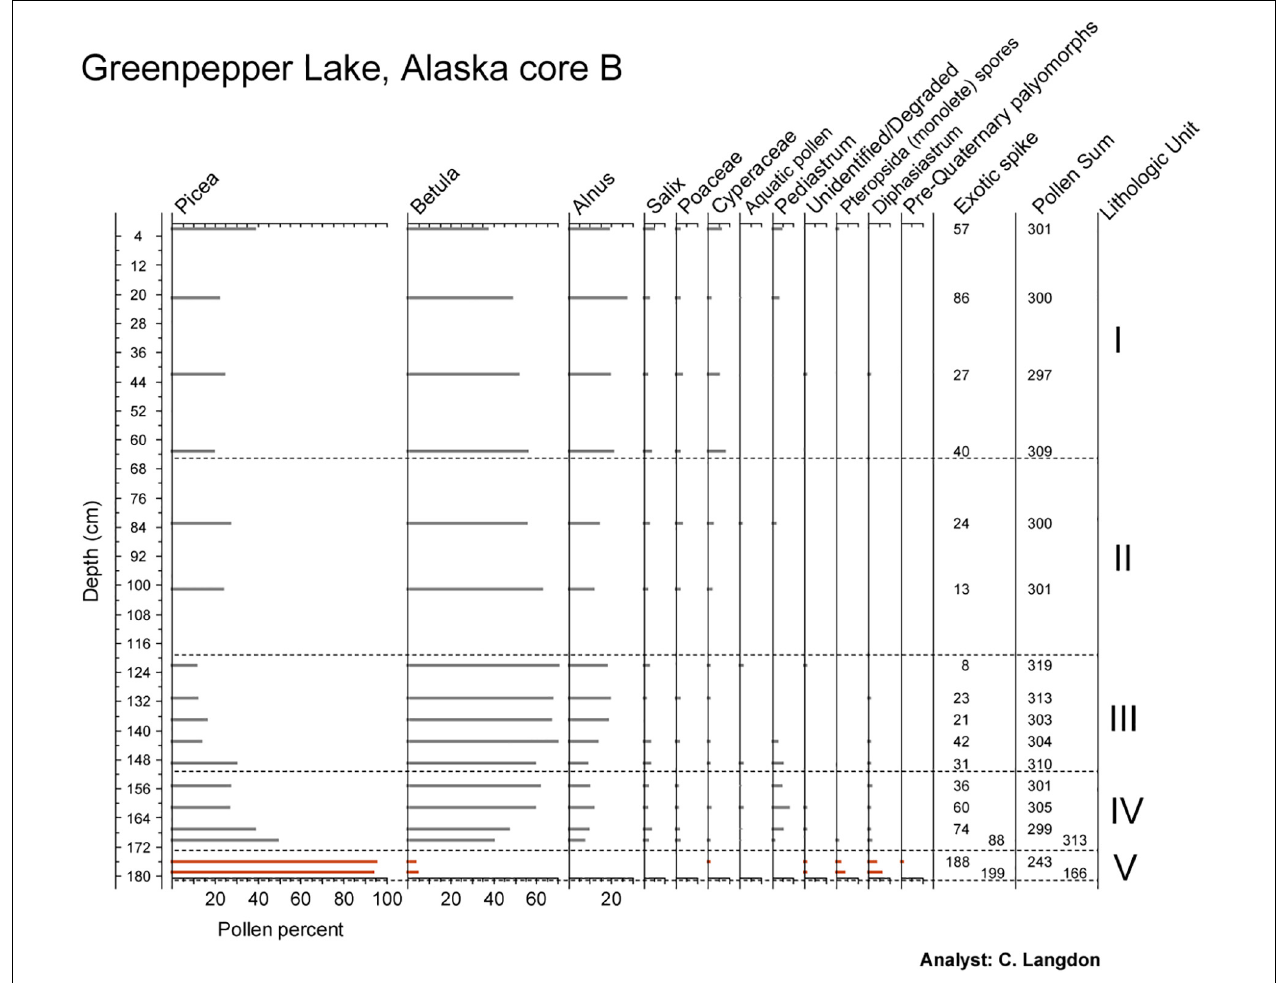
FIGURE 7 | Core B pollen type percentages by core depth with pollen sum amounts. Basal unit V values are highlighted in orange.